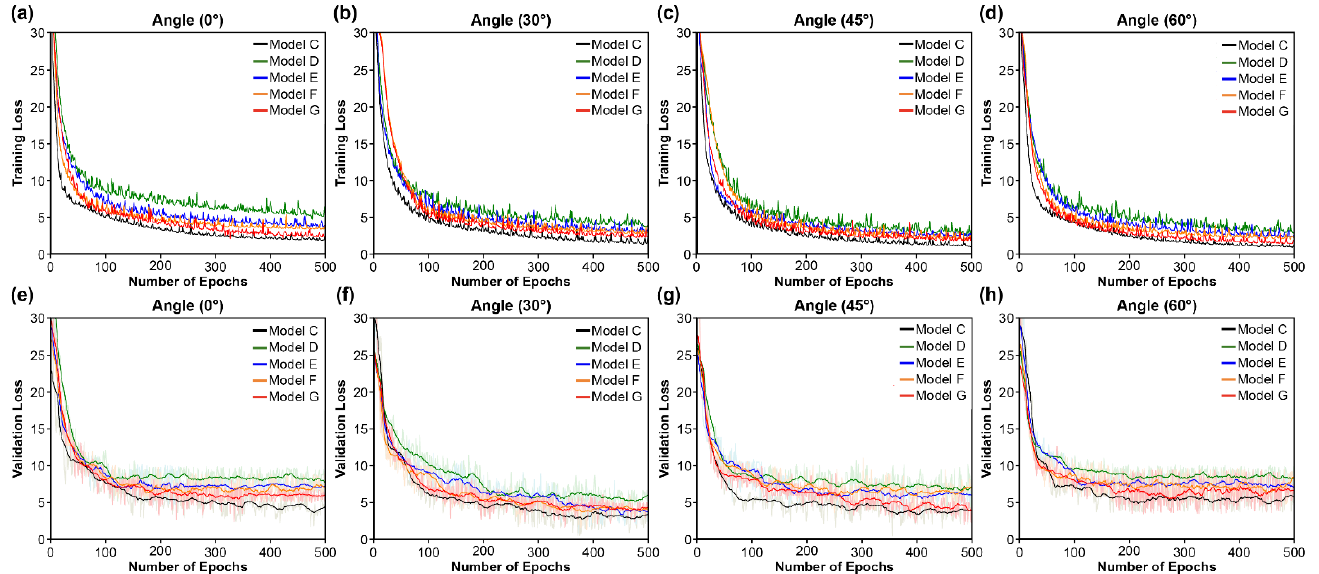
Figure 6. Training and validation loss comparing convergence speed of recurrent layers (Models C, D, E, F, and G). ( a – d ) Training loss at ( a ) 0°; ( b ) 30°; ( c ) 45°; ( d ) 60°. ( e – h ) Validation loss at ( e ) 0°; ( f ) 30°; ( g ) 45°; ( h ) 60°.